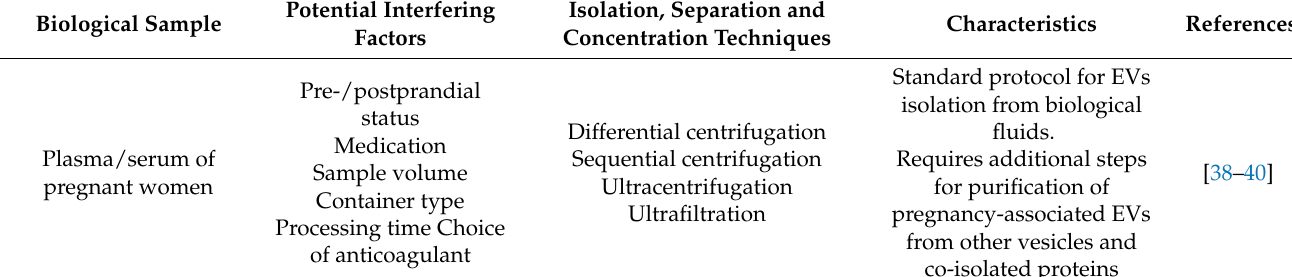
Table 2. Isolation methods used in the detection of pregnancy-related